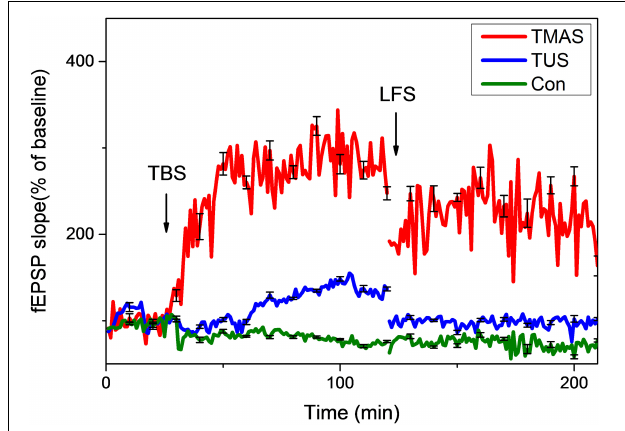
FIGURE 11 | Normalized slopes of fEPSPs in hippocampus of PD mice ( n = 6). Red line, blue line, and green line denote the TMAS group, TUS group, and Con group, respectively.